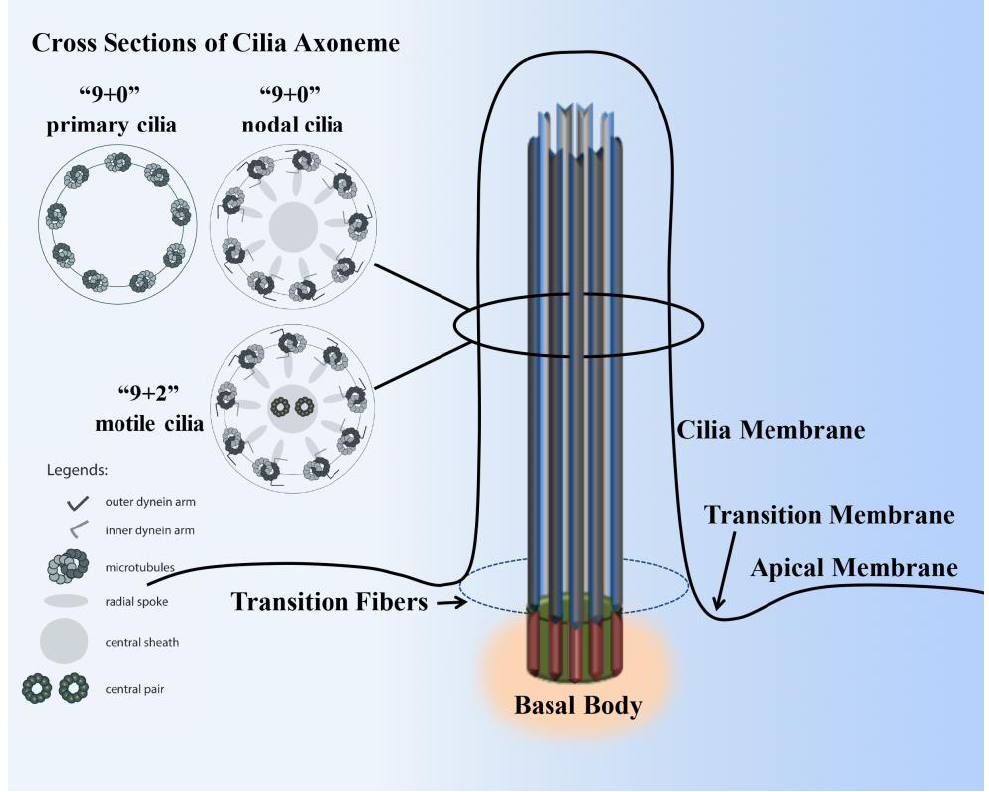
Figure 1. Structure of a cilium. The cilium is a hair-like structure composed of the ciliary membrane, cilioplasm, axoneme, and basal body. This sensory organelle is membrane-bound and contains multiple microtubules running along its length. The ciliary membrane and axoneme make up the upper part of the cilium. The axoneme has nine peripheral microtubule doublets. The axoneme may have two central microtubules (9+2 vs. 9+0 axoneme). The 9+2 cilia usually have dynein arms and radial spokes that link the microtubule doublets and are motile, whereas most 9+0 cilia lack dynein arms, radial spoke, and central sheath and are nonmotile (primary cilia). Some 9+0 cilia only lack the central microtubule and are motile (nodal cilia). The axoneme is enclosed in the ciliary membrane, which is distinct from the cell membrane. Between the cilia and the cell membrane, there is a hypothetical transition membrane surrounding the transition fibers. The transition fibers at the junction of the basal body act as a filter for molecules that can pass into or out of the primary